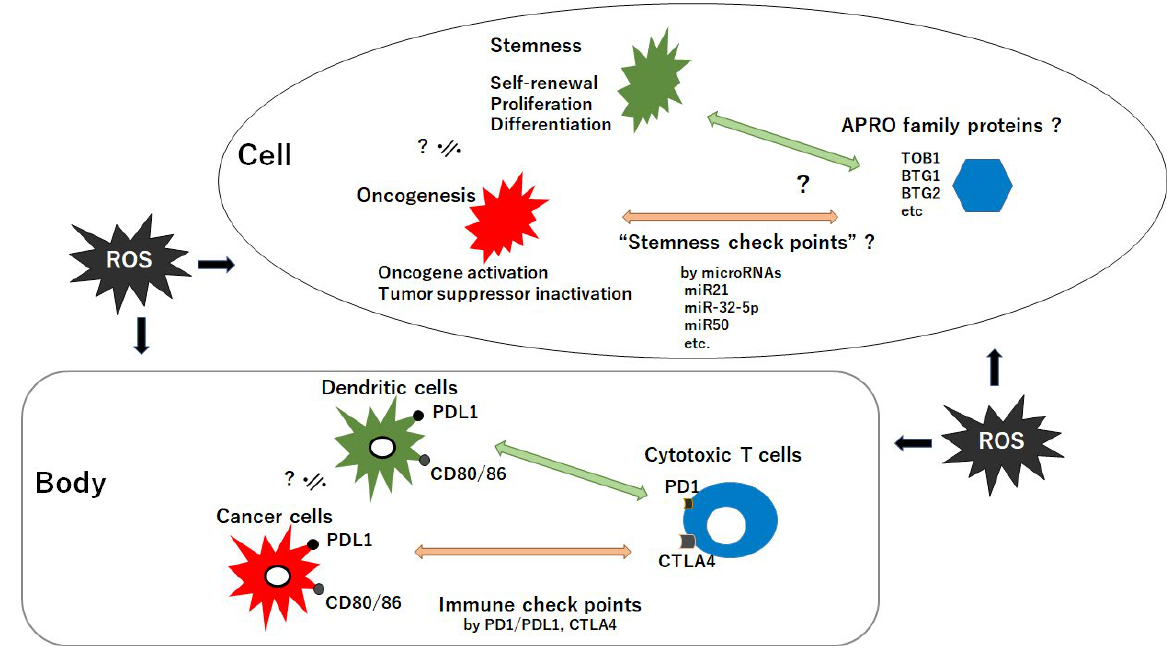
Figure 3. The relationship between tumor suppressor APRO family proteins and oncogenesis/stemness-homeostasis in a cell seems to look like the relationship between cytotoxic T-cells and cancer-cells/dendric-cells in a body. It could be hypothesized that the former may be regulated by “stemness checkpoints” microRNAs for targeting APRO family proteins, whereas the latter is regulated with “immune checkpoints” molecules such as PD1/PDL1 and CTLA4. ROS could affect both. CD: cluster